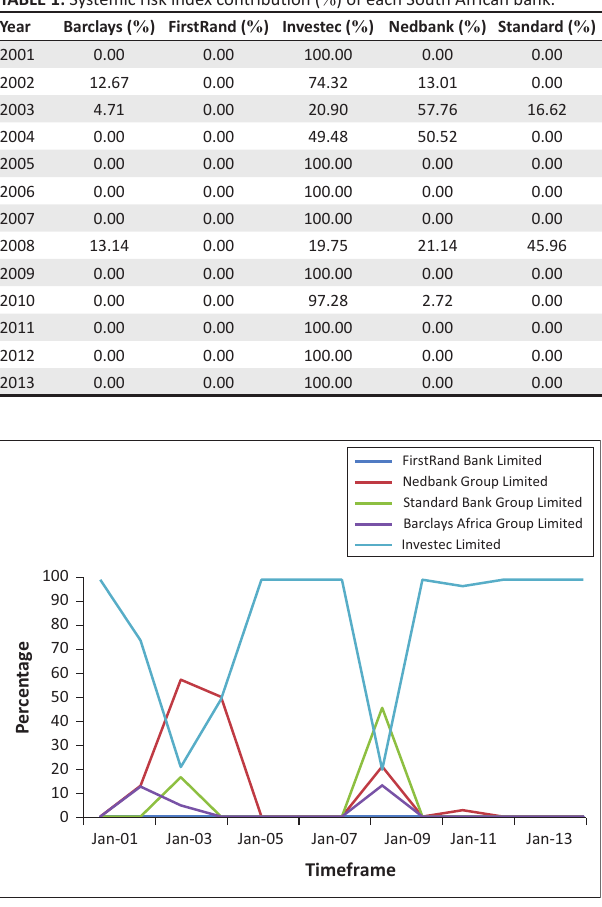
FIGURE 3: Systemic risk index contribution ( % ) of each South African